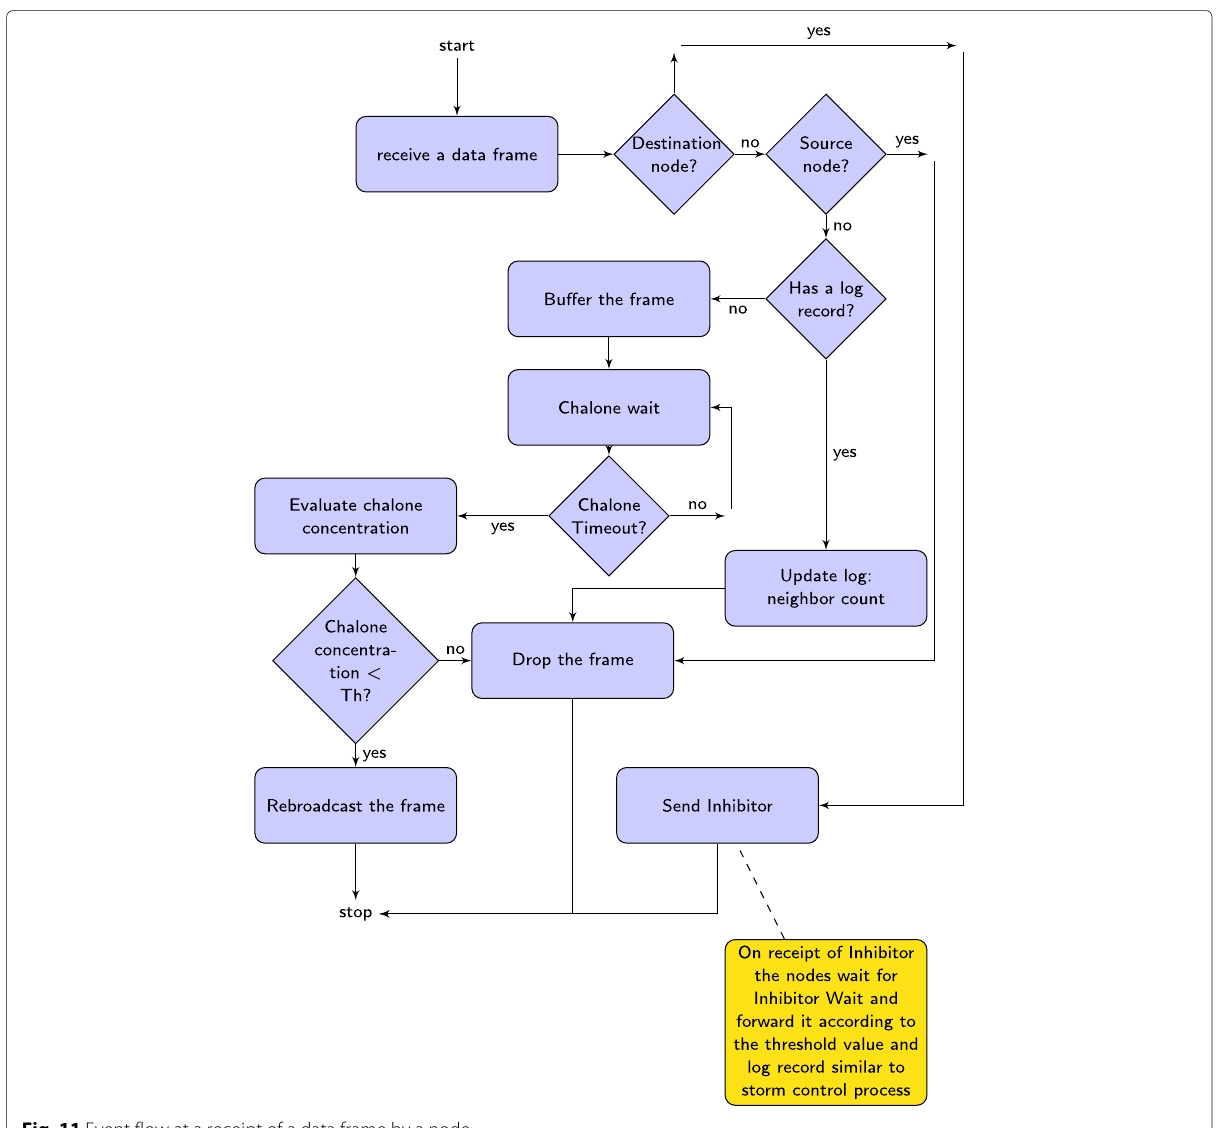
Fig. 11 Event flow at a receipt of a data frame by a node